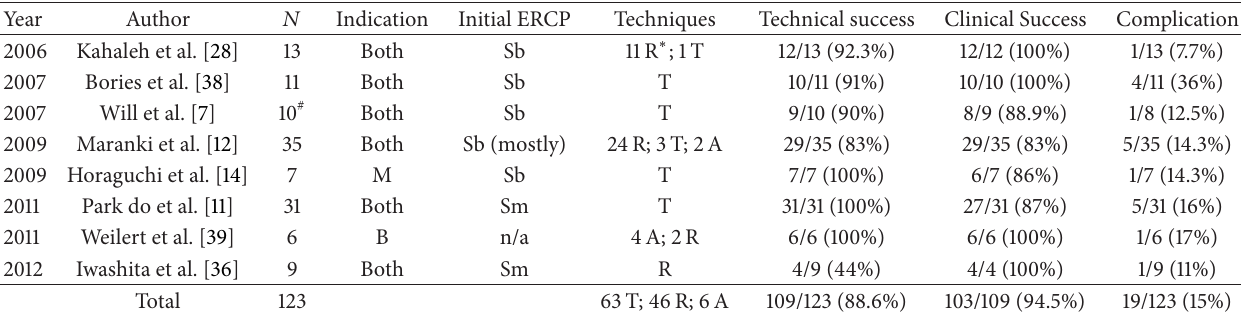
Table 3: Published EUS-CP series on intrahepatic (left) biliary tree drainage (involving ≥ 5